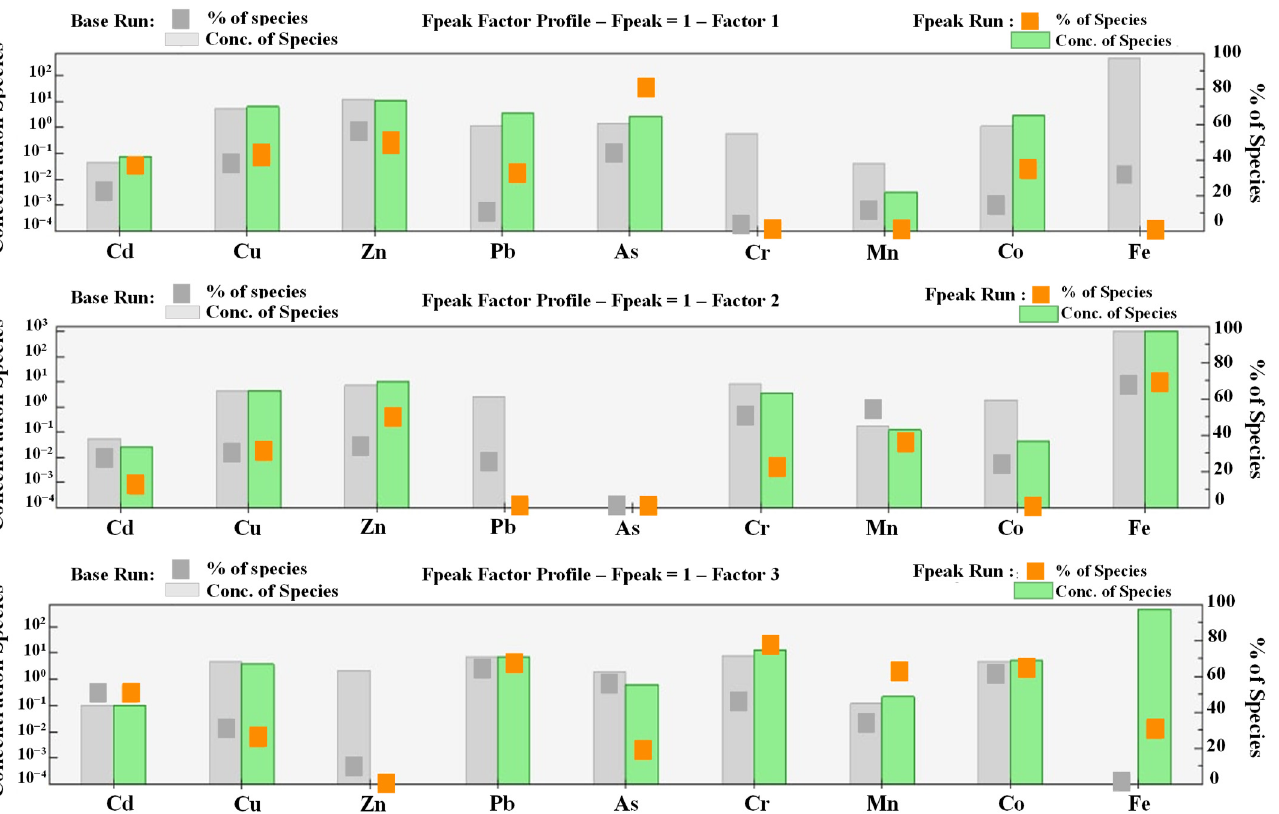
Figure 5. Source profiles of metals and source contribution percentages from the PMF model.